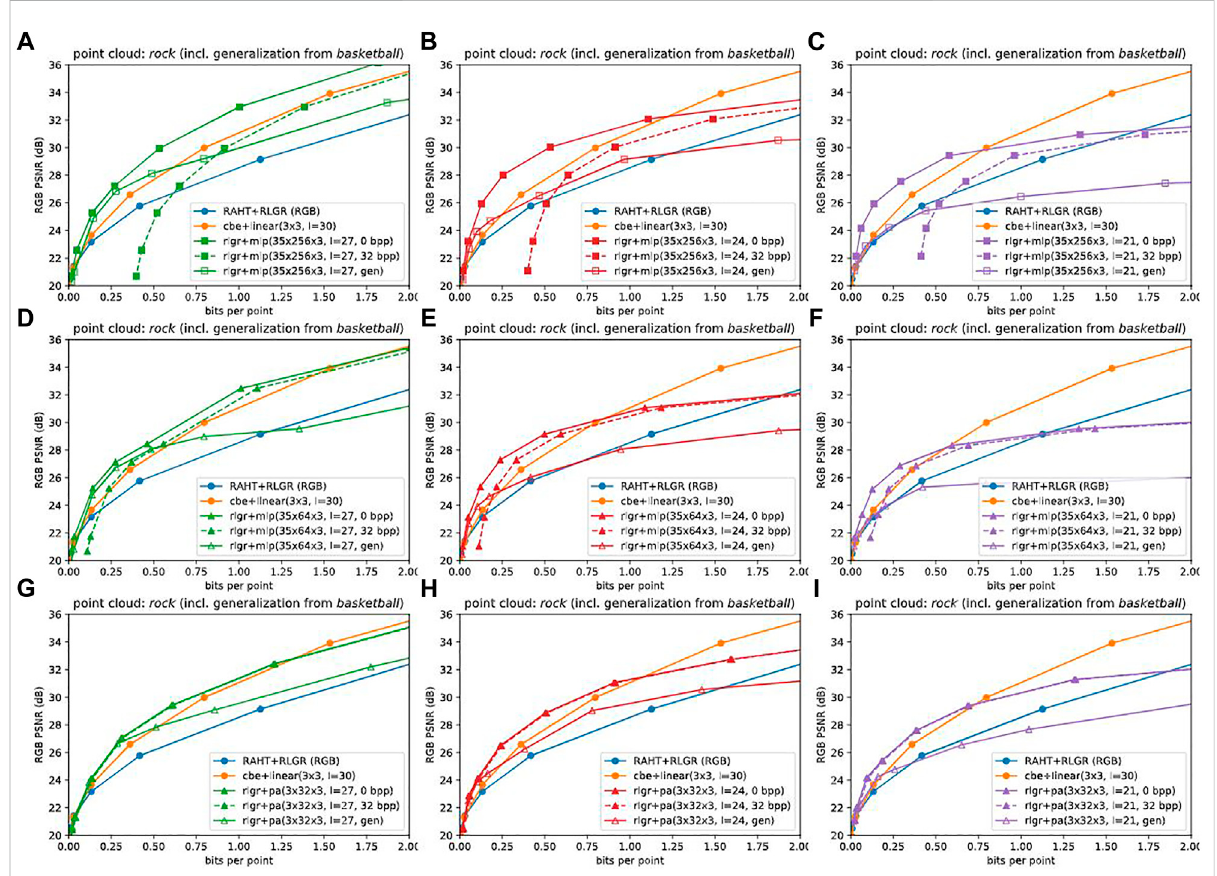
FIGURE 10 Effect of side information for coordinate based networks mlp(35 × 256 × 3) (A – C) , mlp(35 × 64 × 3) (D – F) , and pa(3 × 32 × 3) (G – I) at levels 27 (A,D,G) , 24 (B,E,H) , and 21 (C,F,I) . Sending 32 bits per parameter for the CBN would degrade RD performance from solid to dashed lines. The degradation would be inversely proportional to compression ratio if model compression is used. Alternatively, generalization (pre-training the CBN ononeormoreotherpointclouds),whichworkswellatlowbitrates,wouldobviatetheneedtotransmitanysideinformation.Generalizationis indicated by “ gen ” in the legend.